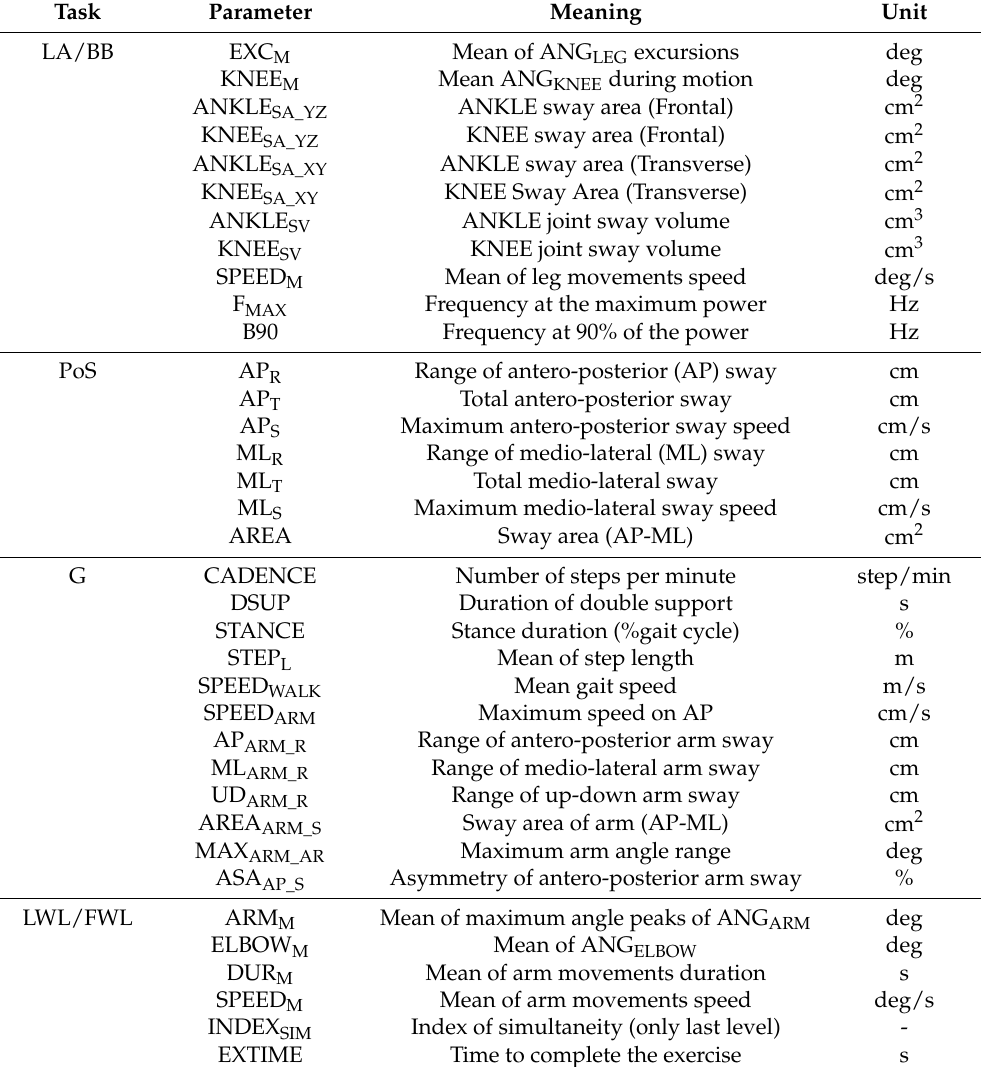
Table 1. Estimated parameters for motor tasks and